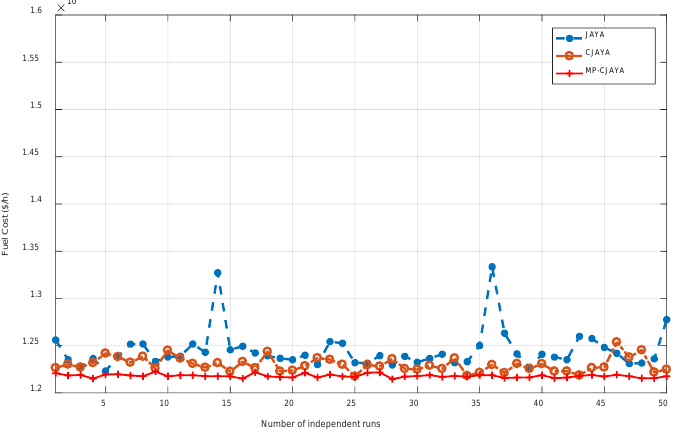
P = 10,500 MW). P = 10,500 MW). Figure 7. Fuel cost for 50 independent runs of 40-units system ( P D = 10,500 D D